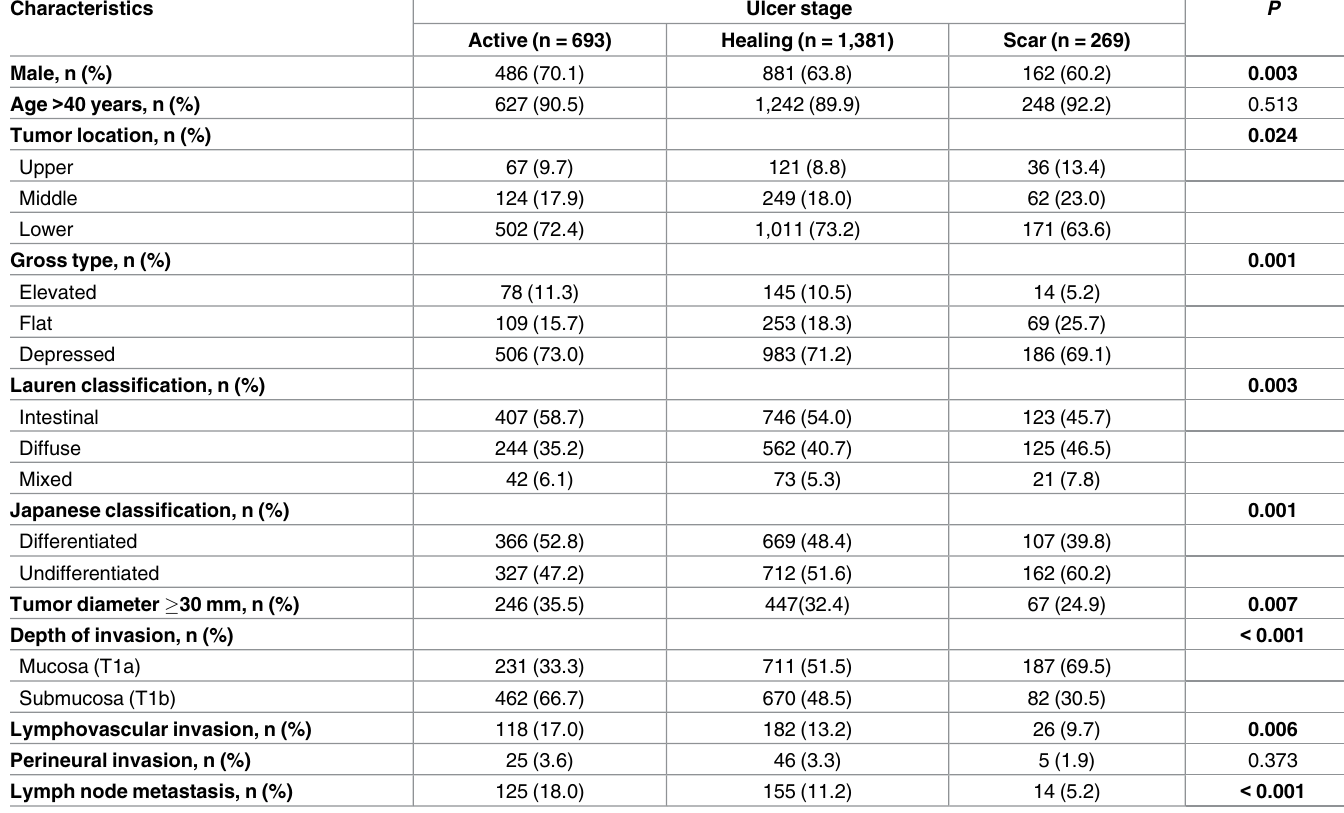
Table 3. Clinicopathologic Factors in Relation to Endoscopic Stage of Ulcer in Early Gastric Cancer (n = 2,343). Characteristics